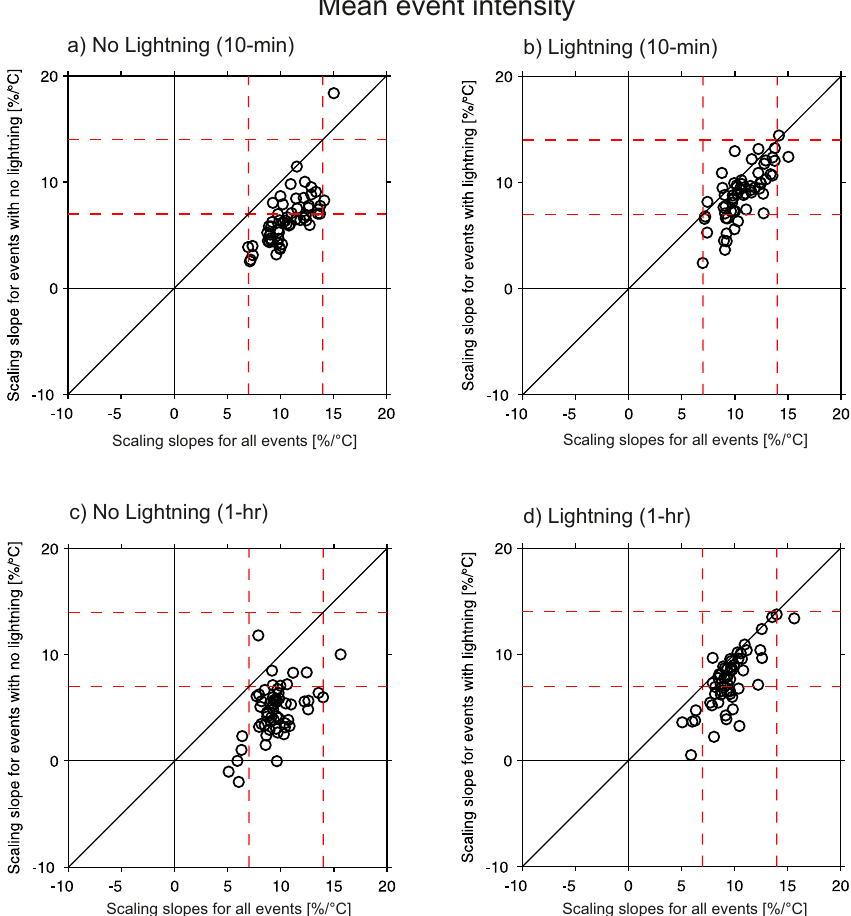
Figure 4. Scatter plots of station-derived estimates of scaling slopes for mean event intensity I m in lightning and no-lightning events versus all events at the (a–b) 10min and (c–d) 1h resolutions using the quantile regression method (95th percentile). Red dashed lines indicate the